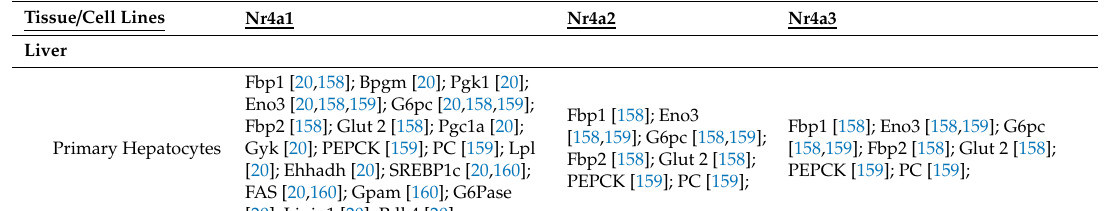
Table 3. Genes regulated by the Nr4a’s that are associated with fuel utilization, defined by tissue of interest. References are given for each